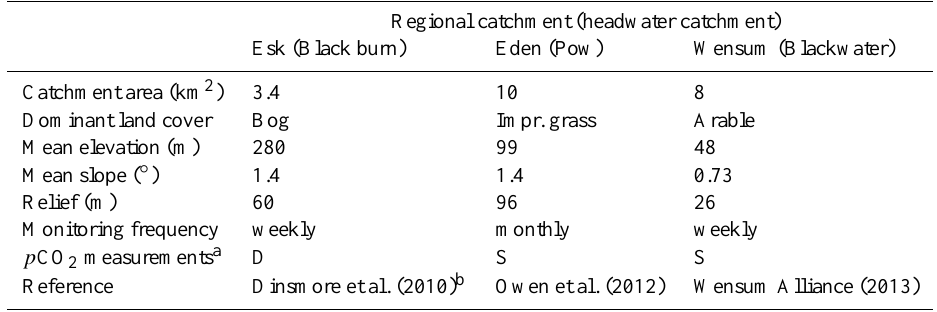
Table 1. Features of three headwater catchments where weekly or monthly stream water measurements or speciation-based estimates of p CO 2 were included in the predictive model (cf: Fig.